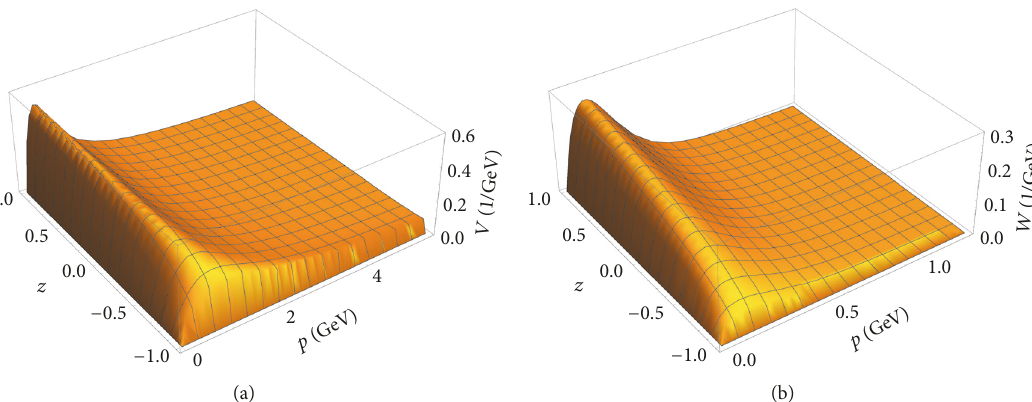
Figure 12: The vector kernel (a) 𝑉( p , q ) (36) and (b) 𝑊( p , q ) (37) obtained from the solution of the quark gap equation for 𝑔 ≃ 2.1 as function of 𝑝 = 𝑞 and 𝑧 = cos ∢( p , q ) [30].